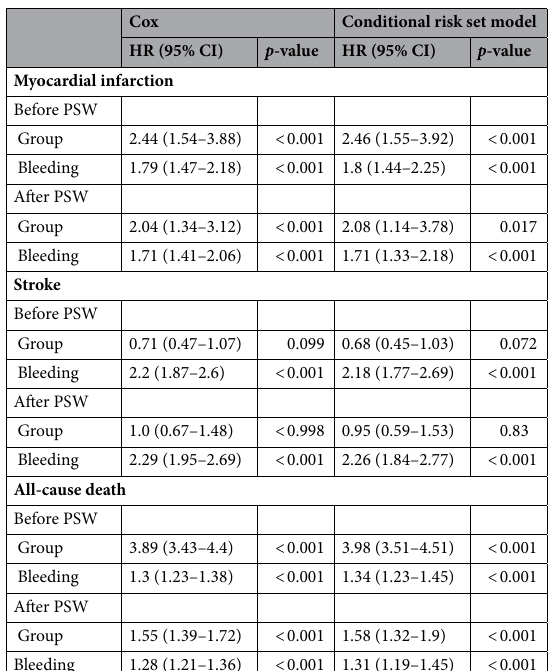
Table 2. Hazard ratios for clinical events in patients with AMI versus CCS where bleeding is treated as a time-dependent covariate. AMI acute myocardial infarction, CCS chronic coronary syndrome, CI confidence interval, HR hazard ratio, PSW propensity score weighting.